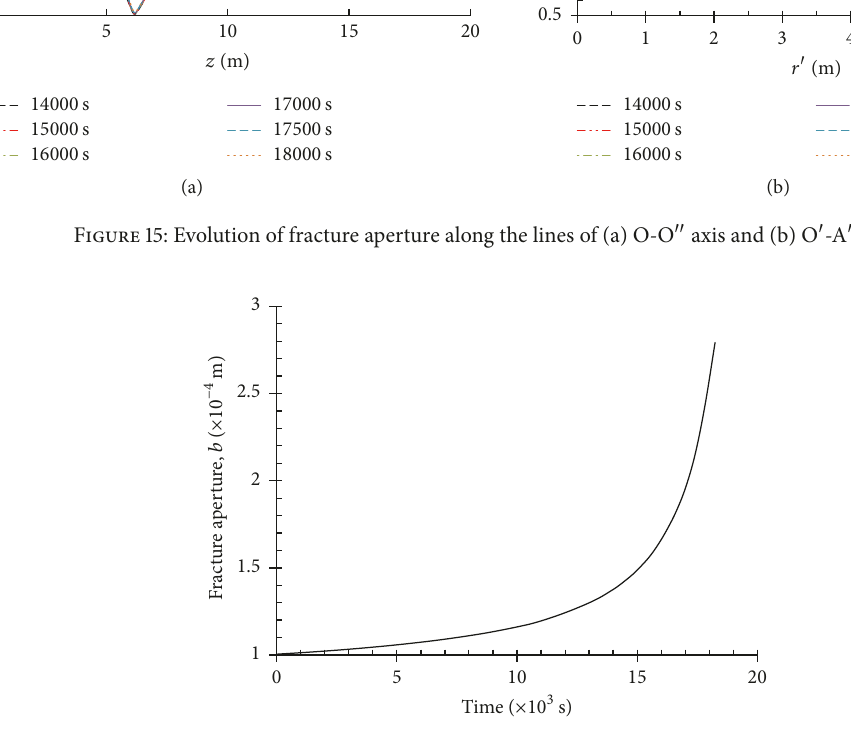
Figure 16: Change of average fracture aperture with